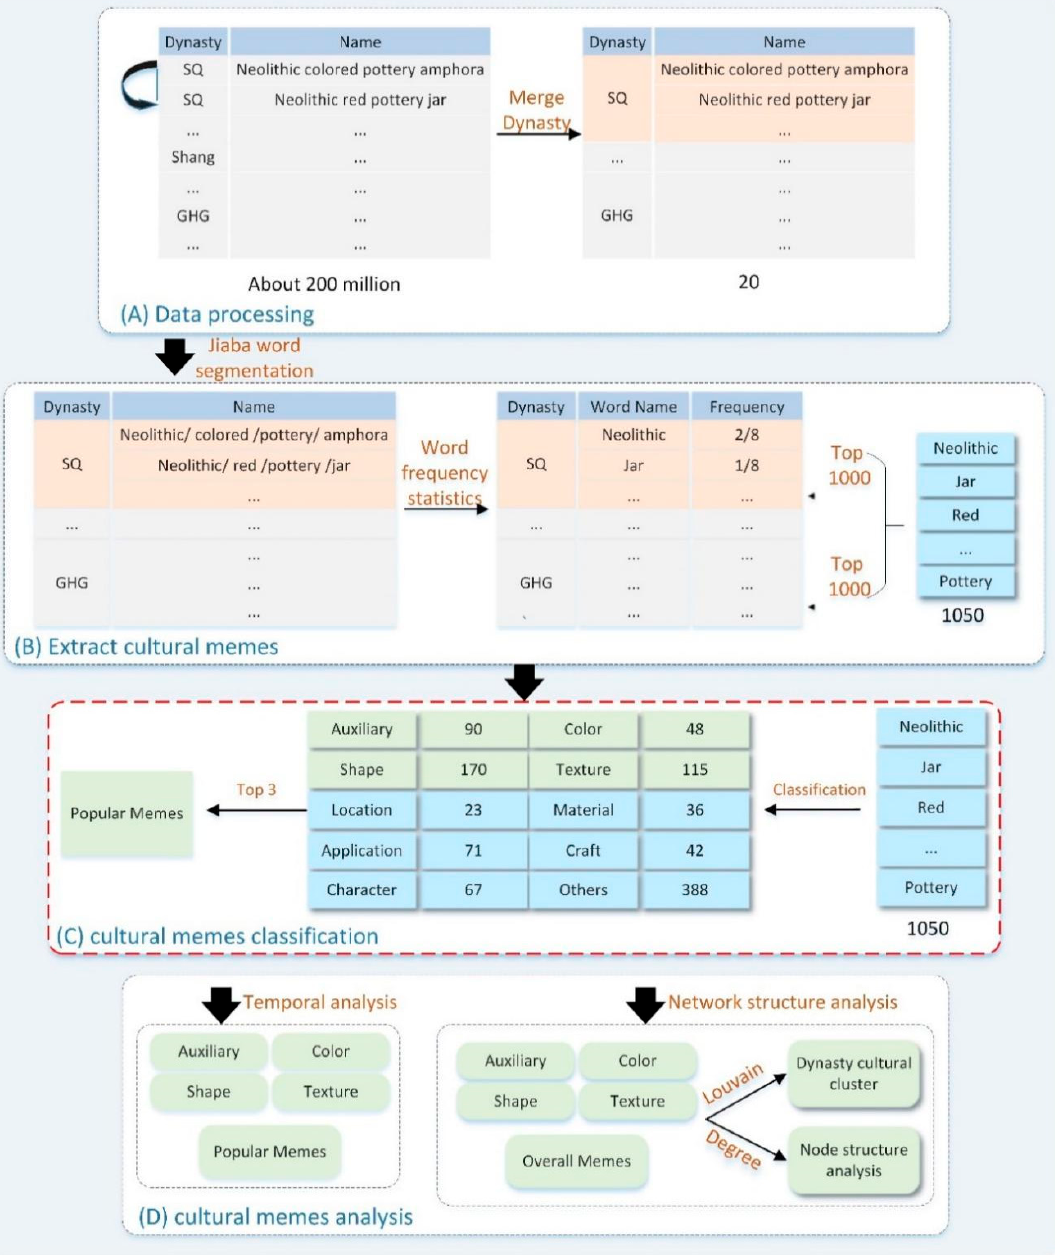
Figure 1. Research framework. ( A ) Data processing; ( B ) Extract cultural memes; ( C ) Cultural memes classification; ( D ) Cultural memes analysis. Table 1. Vector matrix of cultural memes in dynasties.